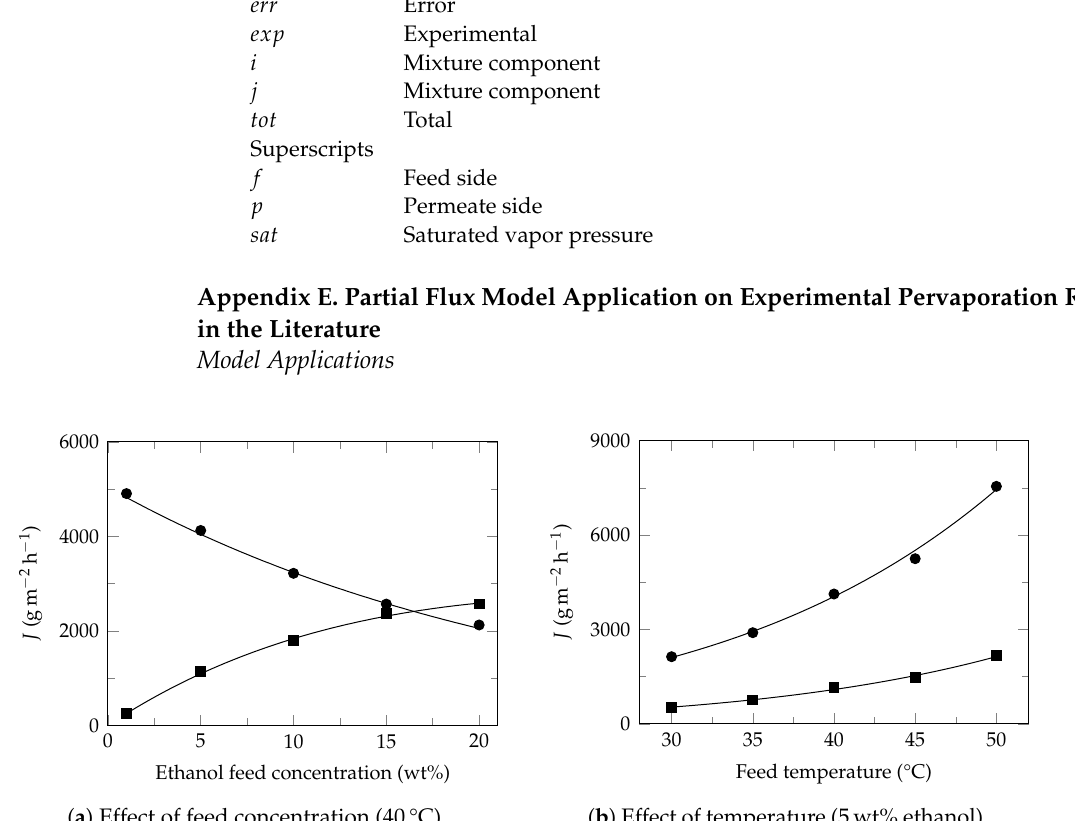
( a ) Effect of feed concentration (40°C). ( b ) Effect of temperature (5wt% ethanol). Figure 8. Ethanol recovery. Experimental data extracted from Wang et al. 2020 [60]. Experimental flux: ethanol ( (cid:4) ) and water ( ). Model flux (—). Pervaporation conditions: membrane: PDMS/UiO-66-TM, effective area: 19.6cm 2 , permeate (cid:32) pressure: 150Pa, Table 4.